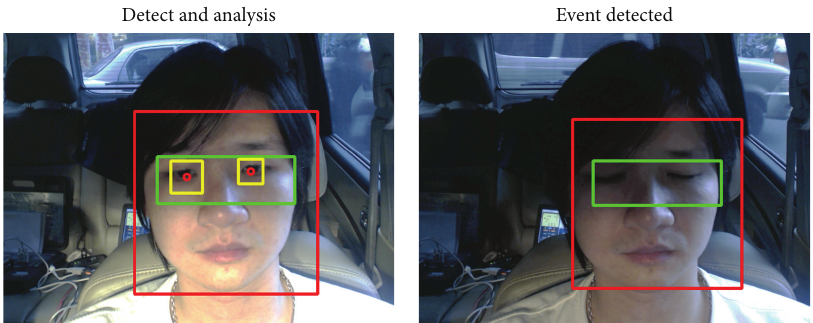
Figure 17: The result of faces and eyes detection and fatigue